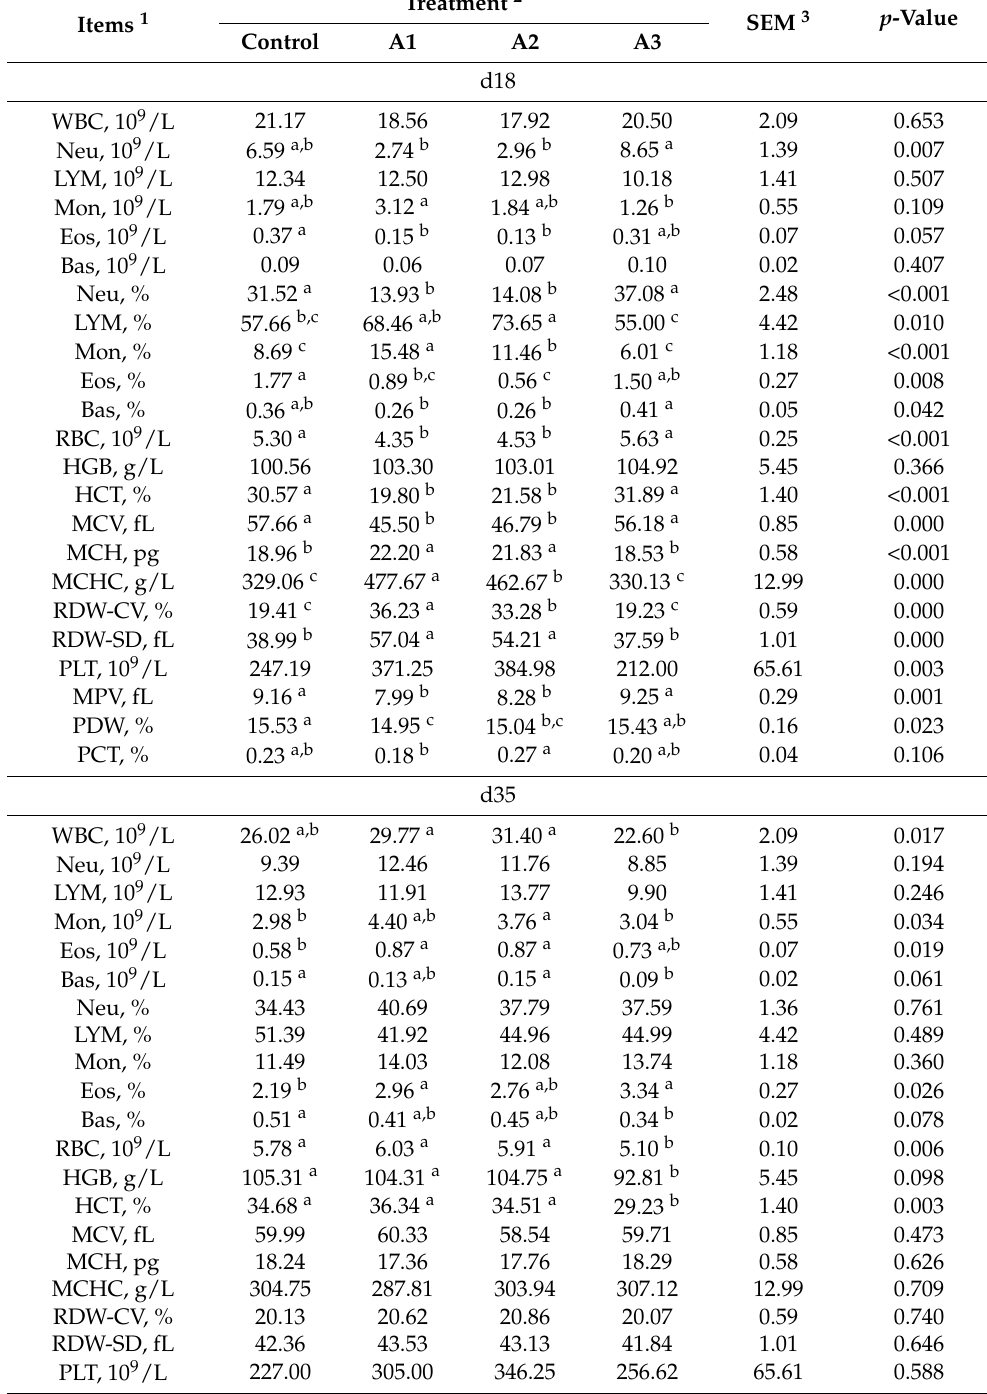
Table 3. Effects of acidifiers on the complete blood count (CBC) test of weaned pigs. Items